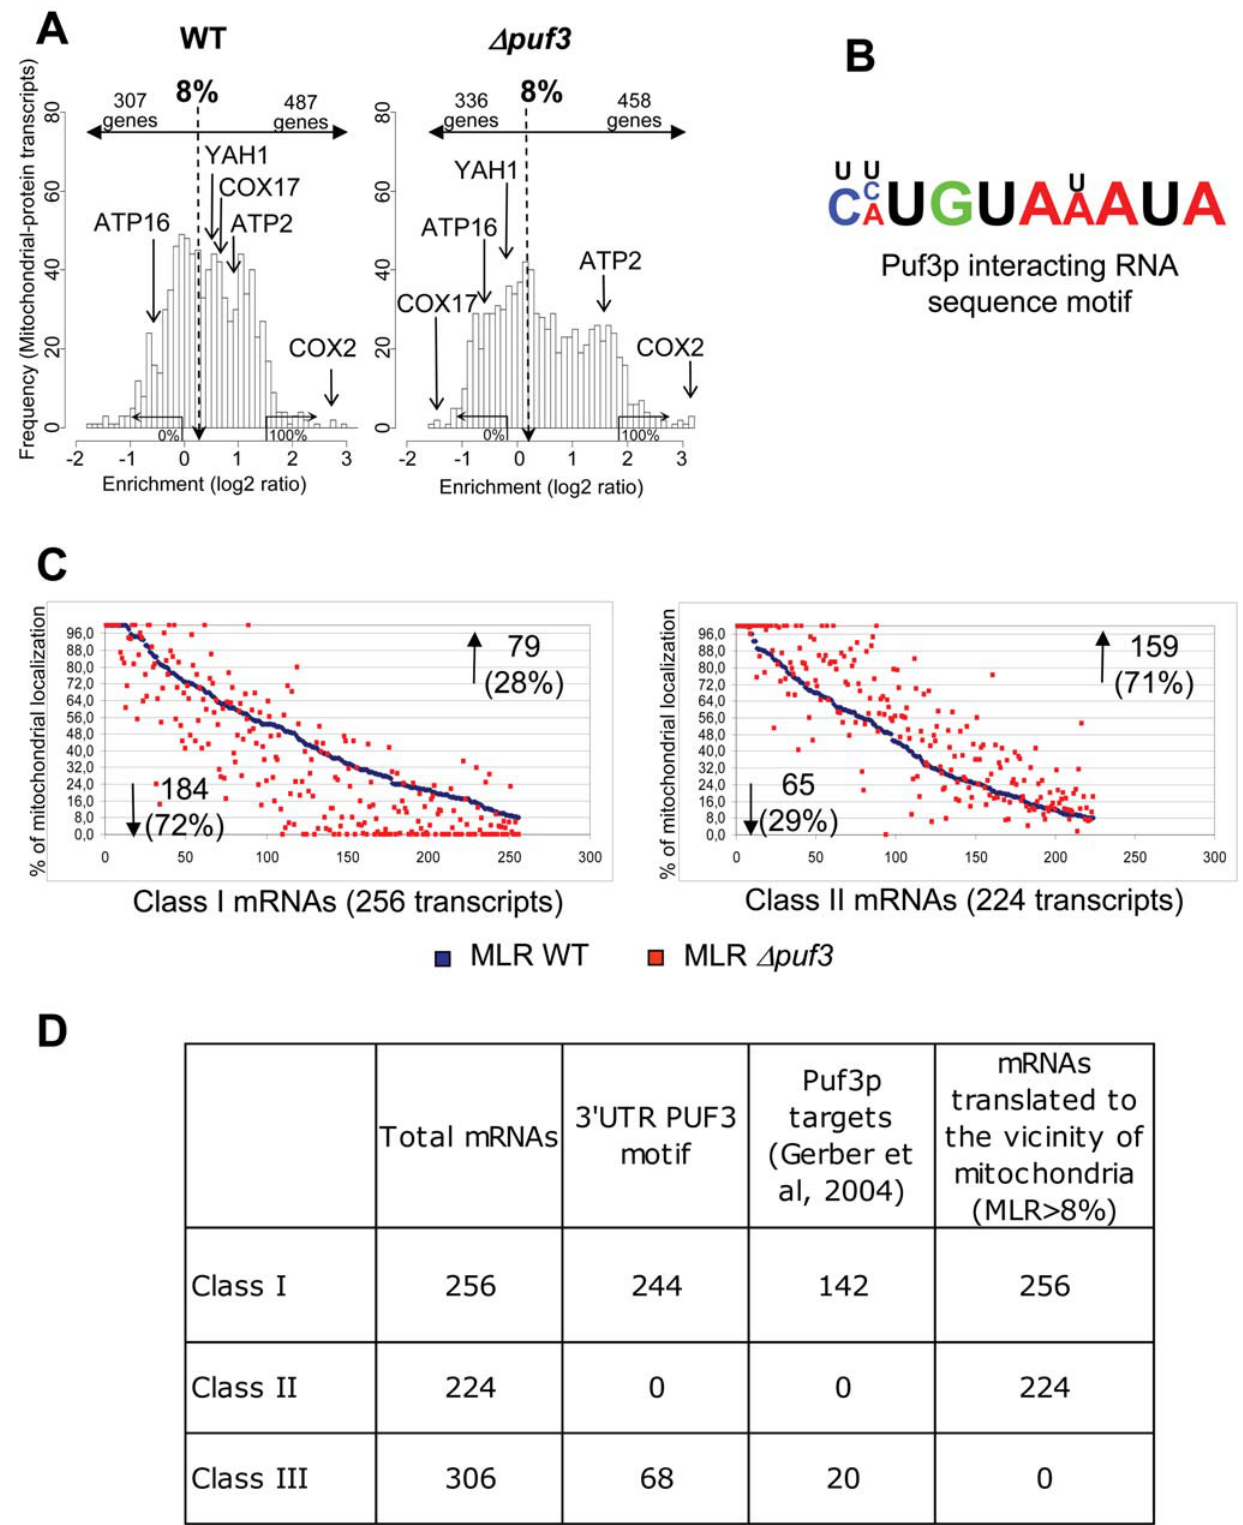
Figure 1. PUF3 deletion affects the asymmetric localization of a specific subclass of MLR-mRNAs A: Distribution of mRNA enrichment in mitochondria preparations for the 794 genes (786 nuclear + 8 mitochondrial genes) encoding mitochondrial proteins. The MLR values are expressed as percentages of mitochondrion-bound mRNA fraction, which are derived from the log2 values (see Materials and Methods). A cutoff value of 8% was statistically determined(seeFigure S1),whichisconsistentwiththe quantitative assessments byRT-PCR ofthe localizationof100mRNAs [12]. The number of genes with significantly asymmetrically localized mRNA is indicated on the right of the 8% threshold value. The 100% arrow indicates the median of the